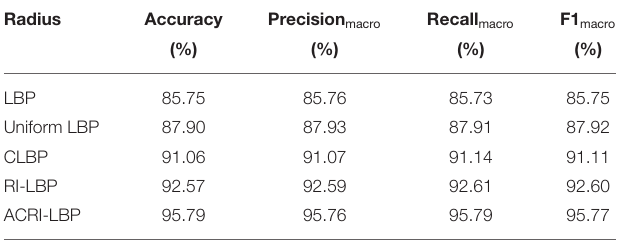
TABLE 3 | Experimental results using different texture extraction